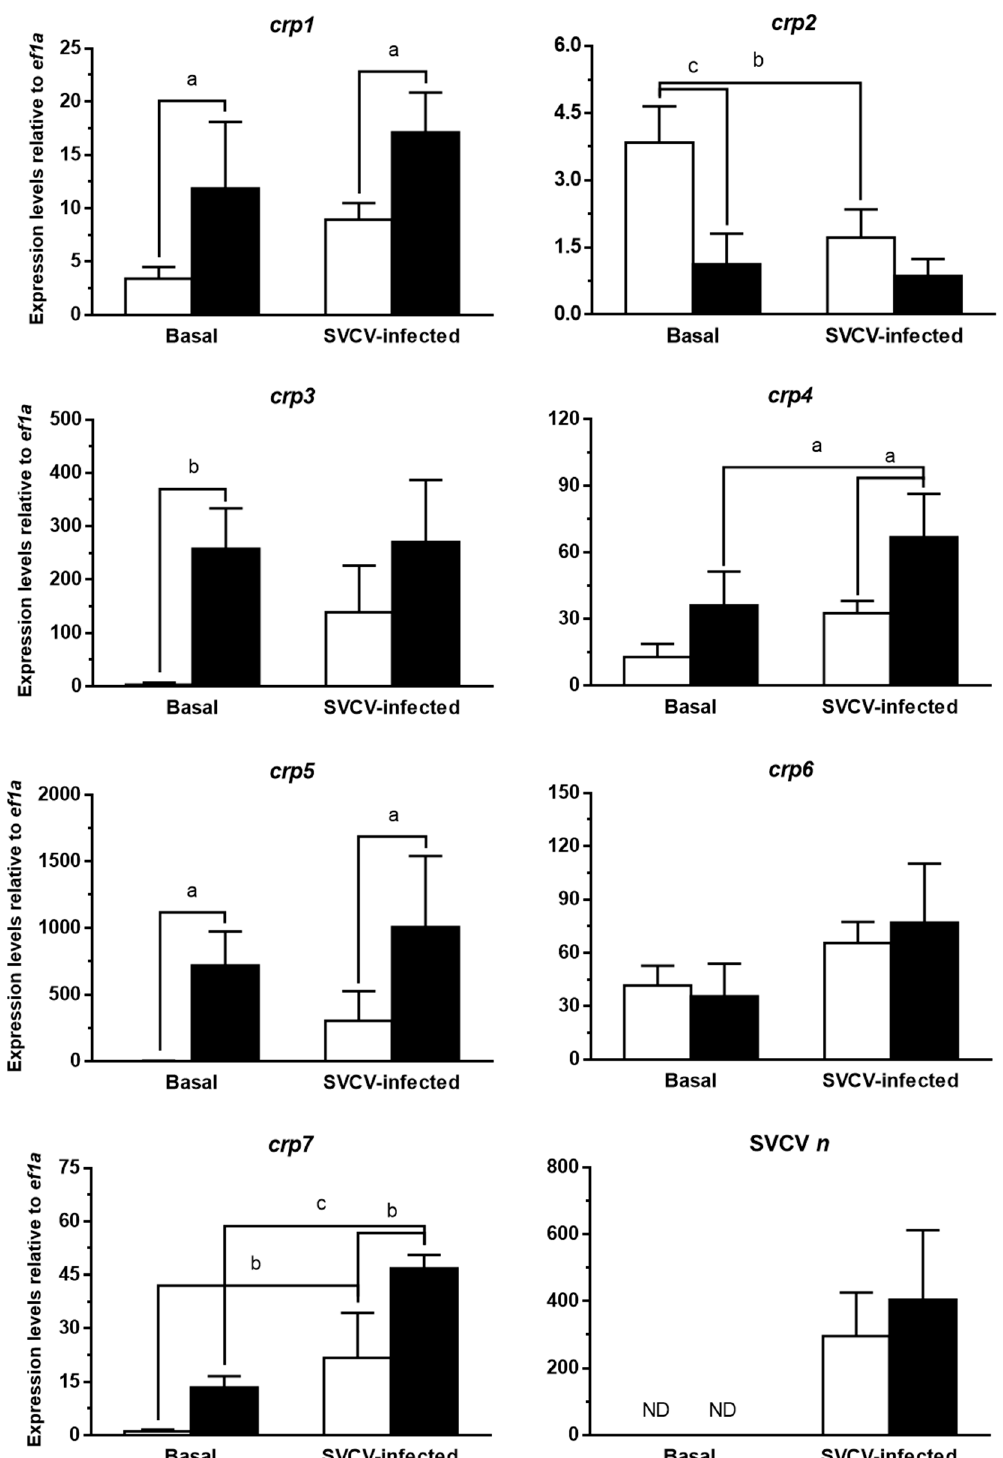
Figure 3. Expression modulation of crp1 – 7 in skin from rag mutant zebrafish in response to SVCV infection. The transcription levels of crp1 – 7 and SVCV n were quantified by RT-qPCR in the skin of rag +/+ (white bars) and rag − / − (black bars) mutant zebrafish at 2 dpi with SVCV. ef1a mRNA was used as the endogenous control to normalize data, which are represented as the mean relative expression level ( × 10 3 for crp s) ± SD of four different individuals. Significant differences were determined by two-way ANOVAs and Sidak’s multiple comparison test. Statistical differences between the experimental groups are represented by keys together with a, b, and c letters on top. a, p ≤ 0.05; b, p ≤ 0.01; c, p ≤ 0.001; ND, not